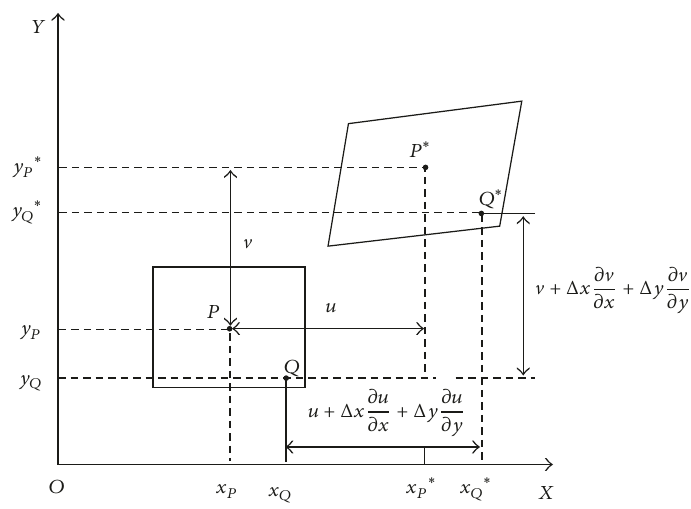
Figure 3: The deformation of the subarea on the surface of the specimen.